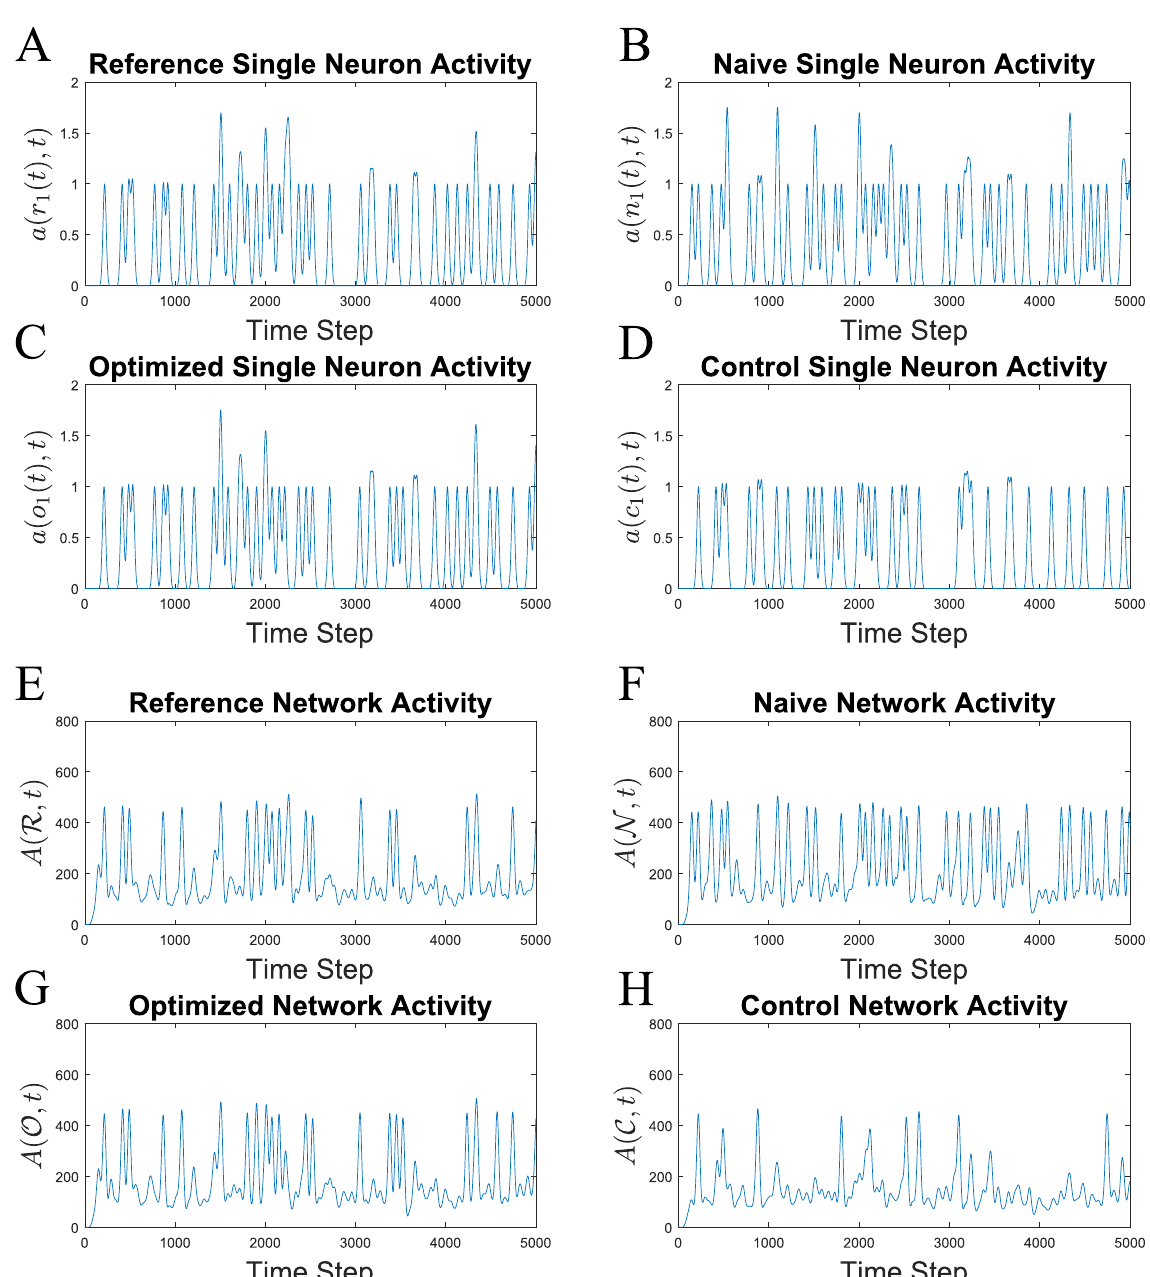
Fig 4. In addition to improving spike train similarity, PSPM also improves agreement with voltage traces. Example voltage traces are plotted for a single neuron over 200 timesteps. All neurons in the network are driven with the same input currents so the differences in dynamics between networks is only due to the different weight matrices. The reference ( A ) and optimized ( C ) show most similar traces with spikes at 25 and 100 timesteps. The same neuron in the naive network ( B ) has only one spike, and it occurs later than the desired time. During PSPM, weight matrices are learned to reproduce the correct spike times, evidenced by the optimized trace ( C ). The control network ( D ) is given overall homeostatic adjustments that keep total network activity at the desired level but the spike times are different. Note that the second spike in the control network occurs later than the reference